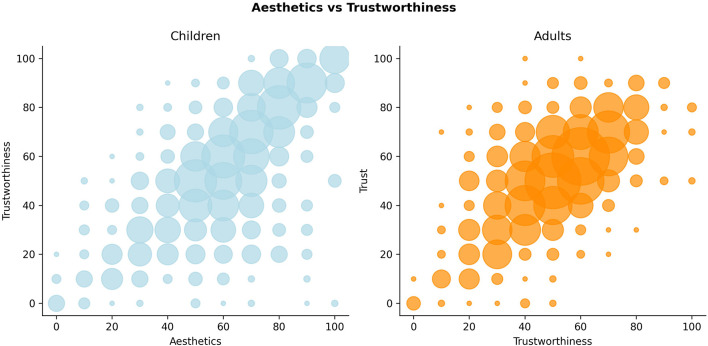
Distribution of aesthetics and trustworthiness judgments by age.